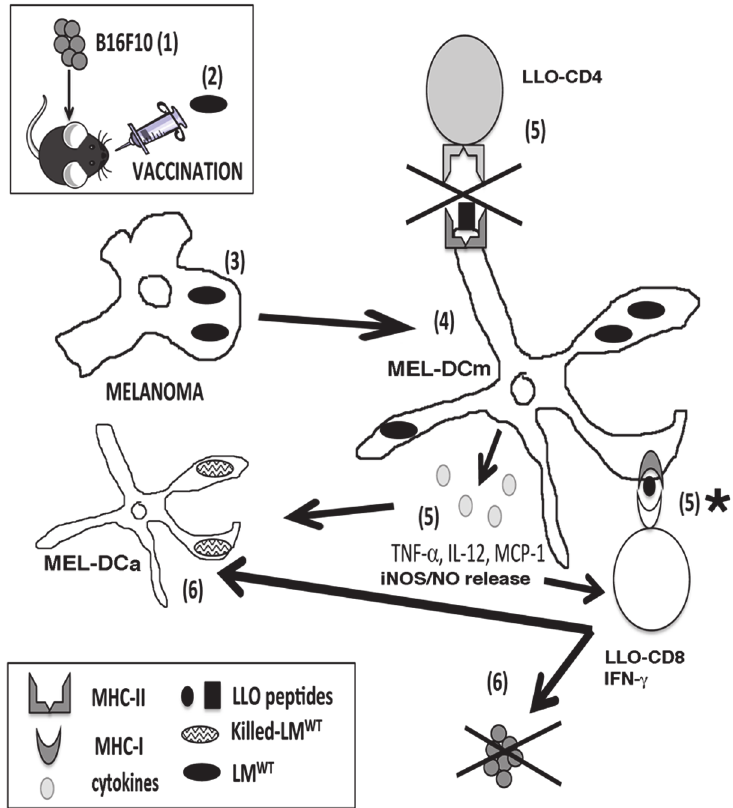
Fig 4. Model of action of our LM WT vaccination of melanoma. After LM WT vaccination of melanoma induce mice, bacteria would infect the melanoma and transformed them into matured dendritic-like cells (MEL-DCm) ( step 4 ) with APC competence to process LLO and generate LLO 189 – 201 /CD4 + -restricted and LLO 91 – 99 /CD8 + restricted peptides. Melanoma transformation into DCm generates exaggerated levels of the pro-inflammatory cytokines/chemokines, MCP-1, TNF-alfa and IL-12 ( step 5 ), amplifies the activation of LLO 91 – 99 /CD8 + -restricted T cells ( step 5 ) and blocks the stimulation of LLO 189 – 201 /CD4 + -restricted T cells ( step 5 ). The exaggerated levels of pro-inflammatory cytokines and the amplification of LLO 91 – 99 /CD8 + - restricted T cells producing high levels of IFN-gamma, strongly activated innate cells with tumoricidal potential. The amplification of LLO 91 – 99 /CD8 + -restricted T cells would cause a LLO-driven tumour destruction by programmed cell death ( step 6 ). Also these LLO 91 – 99 /CD8 + -restricted T cells producing high levels of IFN- gamma would activate the LM WT infected melanoma (MEL-Dm) to a fully activated state (MEL-DCma) that might eliminate the pathogen ( step 6 ) with the advantage of not requiring antibiotic treatment to destroy this low dose of the pathogen used as therapeutic